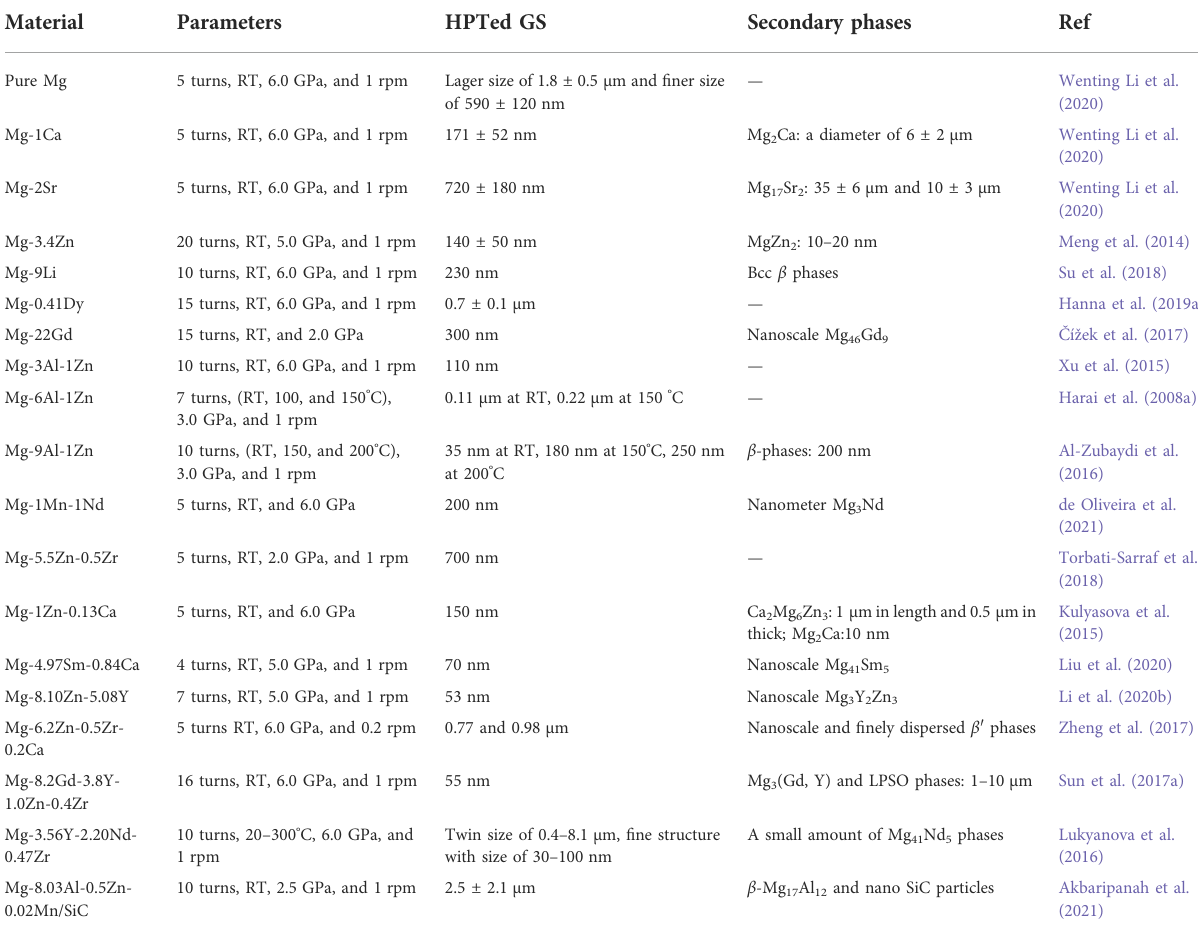
TABLE 1 Microstructural evolution of Mg alloys processed by